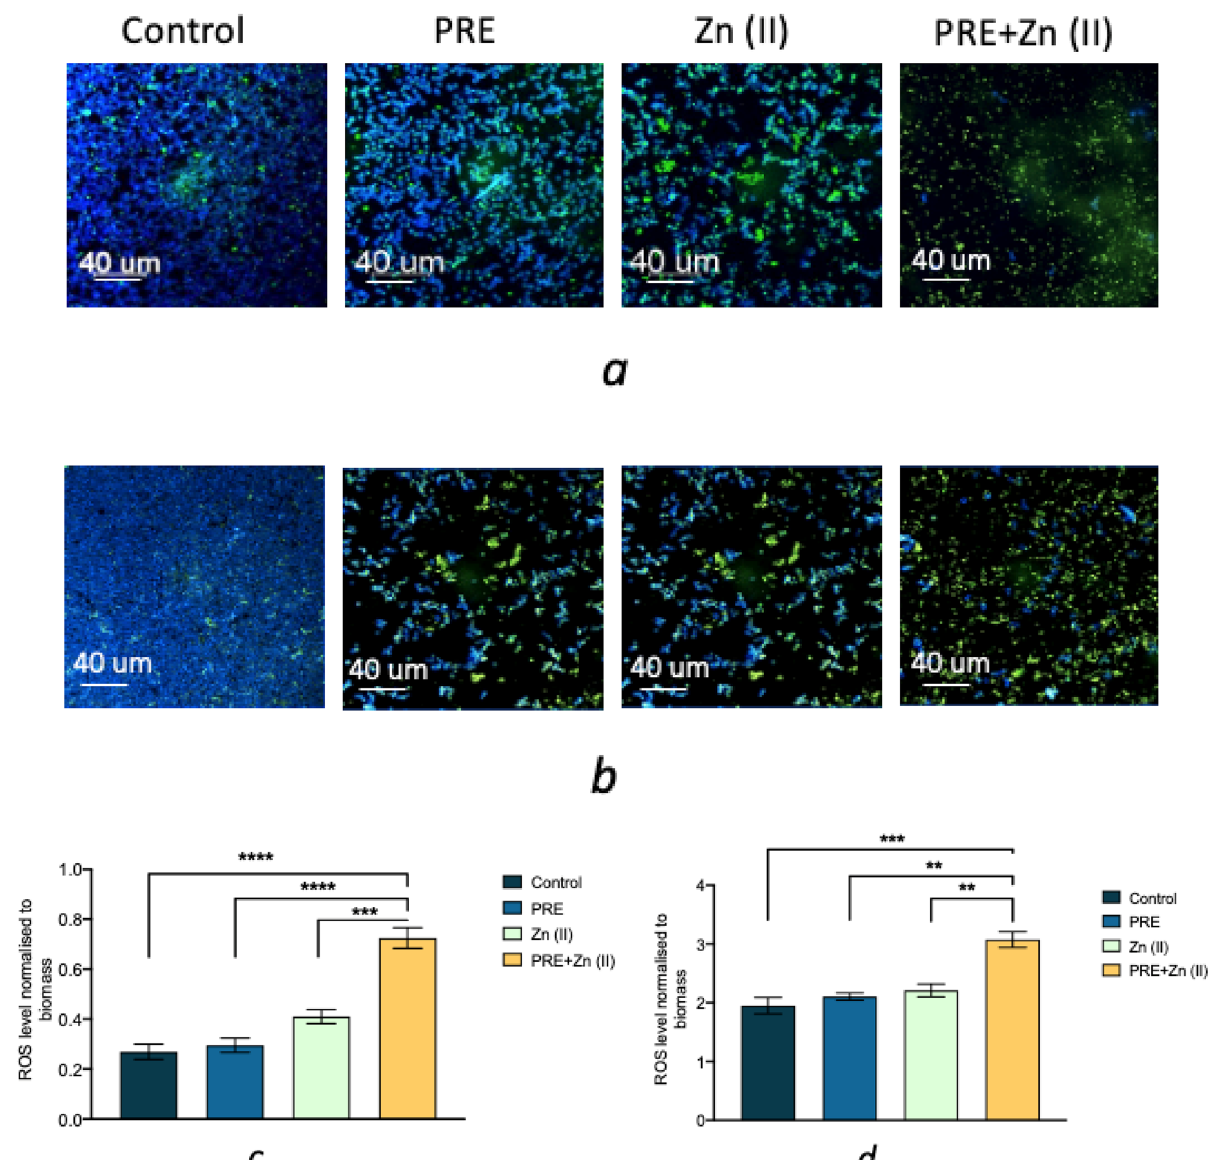
Figure 4. CLSM images of C. albicans in planktonic ( a ) and biofilm form ( b ) incubated with PRE (4 mg/mL), Zn (II) (1.8 mg/mL) and PRE and Zn (II) combined (4 mg/mL + 1.8 mg/mL) for 24 h. Blue channel shows calcofluor in C. albicans cells walls and green channel shows ROS production in C. albicans cells. Graphs shows ROS levels for C. albicans in planktonic form ( c ) and biofilm form ( d ) normalised to total biomass. Significance indicated by *, where **p < 0.01, ***p < 0.001, and **** p < 0.0001. Data represented as mean ± SEM (n =